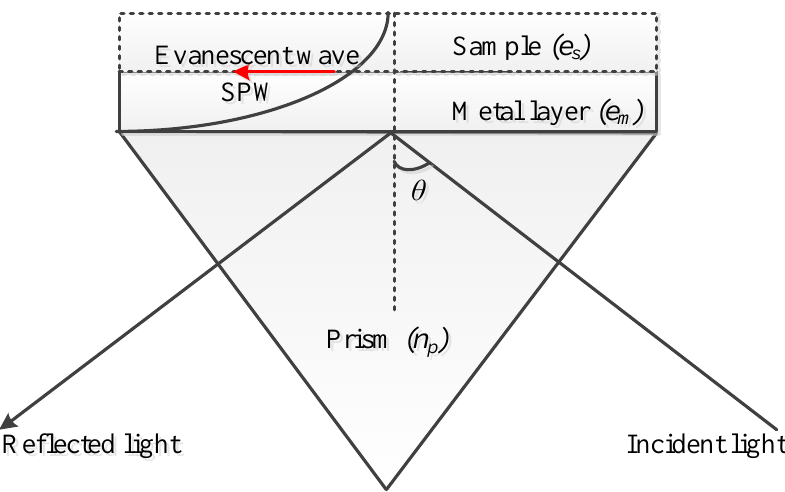
where e s , e m and n p represent the dielectric constant of sample or dielectric medium, dielectric constant of the plasmonic material (metal), and the refractive index of the material of the prism, respectively. In addition, ω is the angular frequency, c is the speed of light in a vacuum, and θ is the angle of incidence of light.